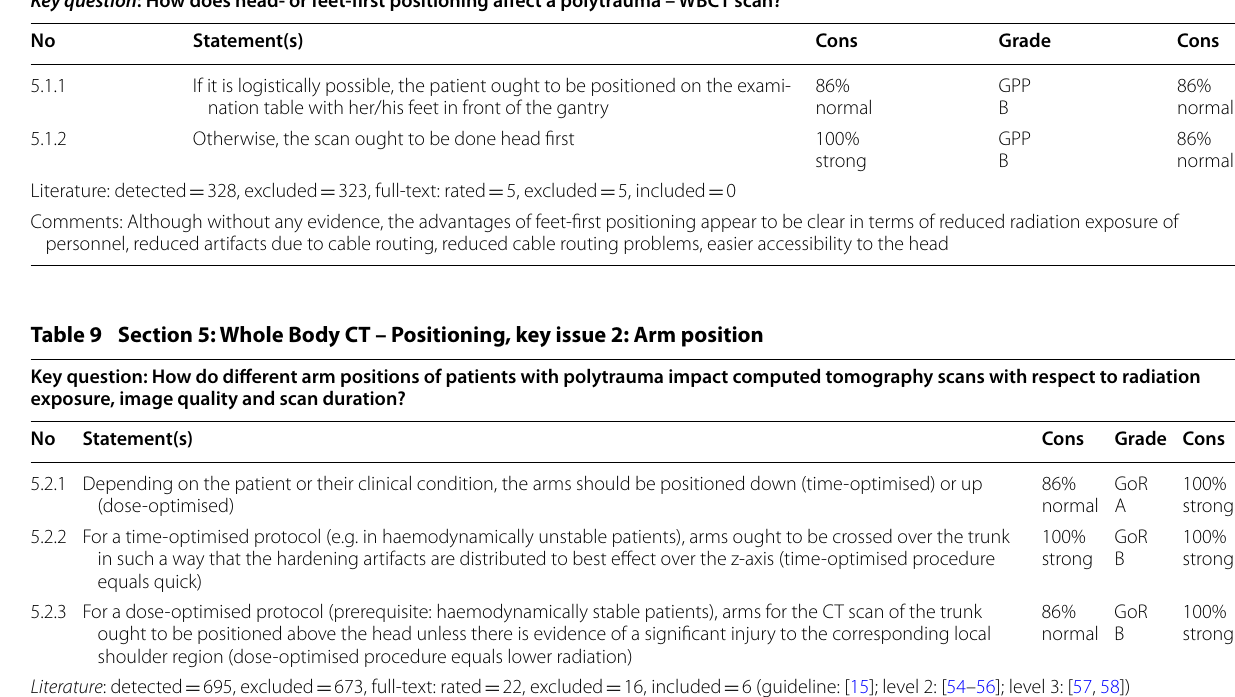
Table 8 Section 5: Whole Body CT – Positioning, key issue 1: patient orientation Key question : How does head- or feet-first positioning affect a polytrauma – WBCT scan?